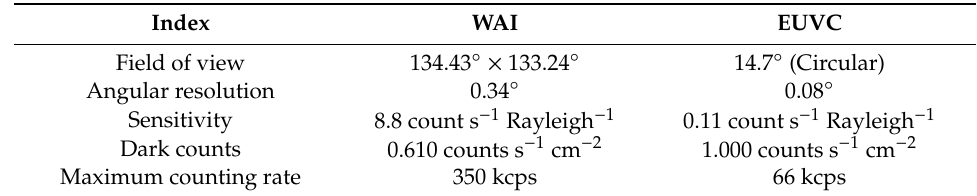
Table 1. Test Results of WAI and EUVC.